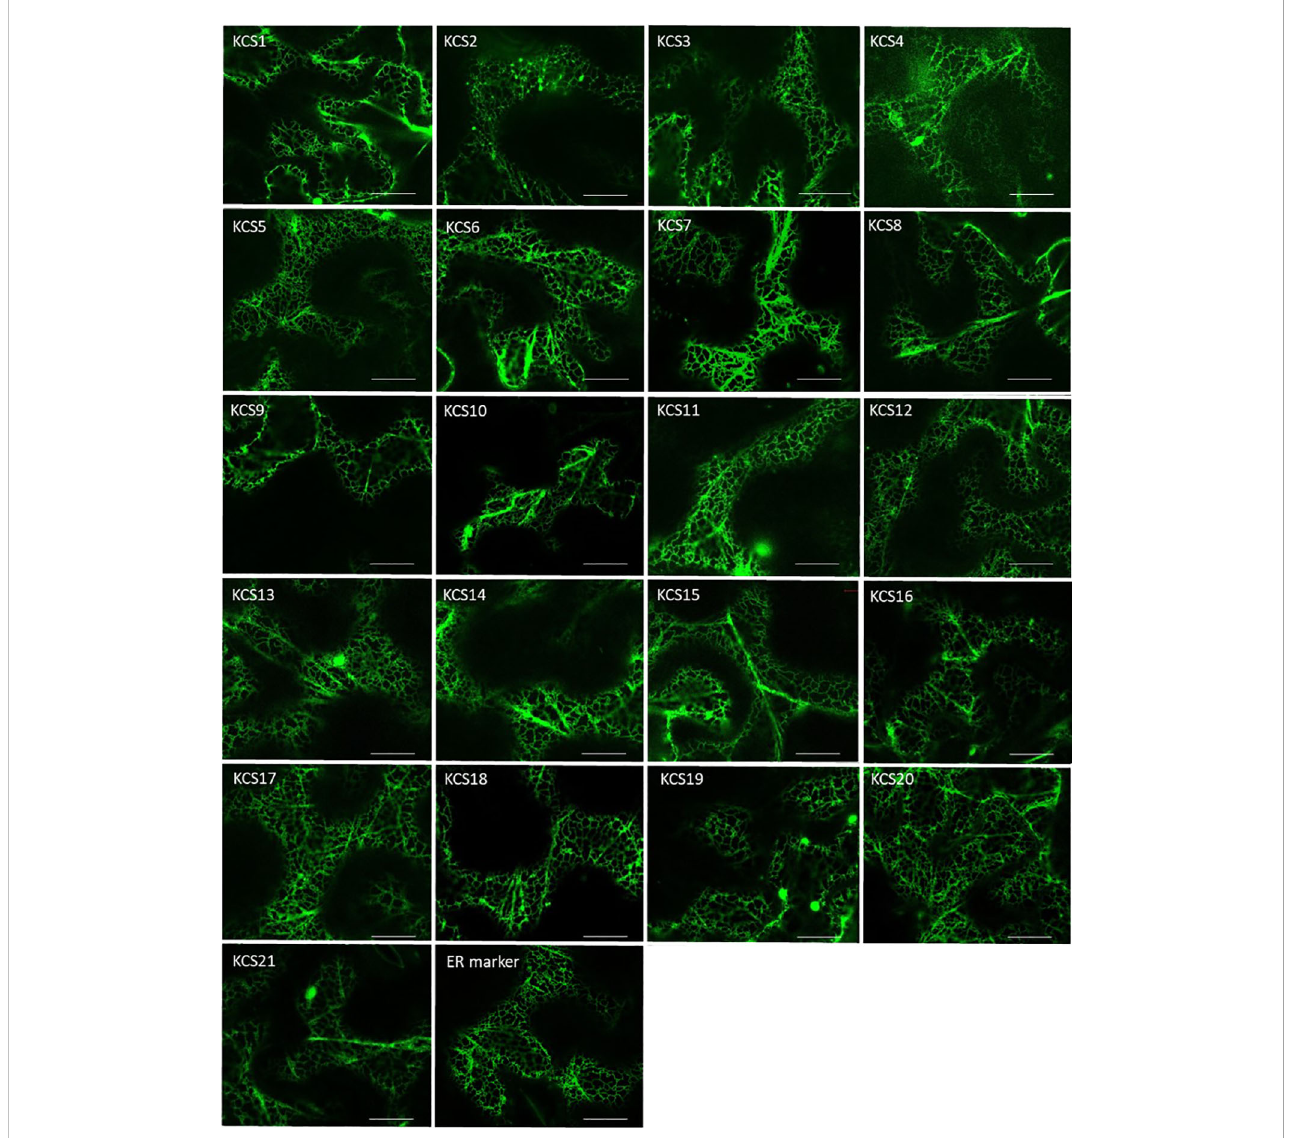
FIGURE 5 The 21 Arabidopsis KCSs localize in the endoplasmic reticulum of tobacco cells. Confocal images of Nicotiana benthamiana leaves transiently transformed with KCS-YFP constructs. The 21 Arabidopsis KCS ORFs have been cloned into the pK7YWG2 destination vector, transferred into the Agrobacterium tumefaciens strain GV3101 and used for transient expression in leaves. The plasmid ER-gk CD3-955 was used as an ER marker. Bars =